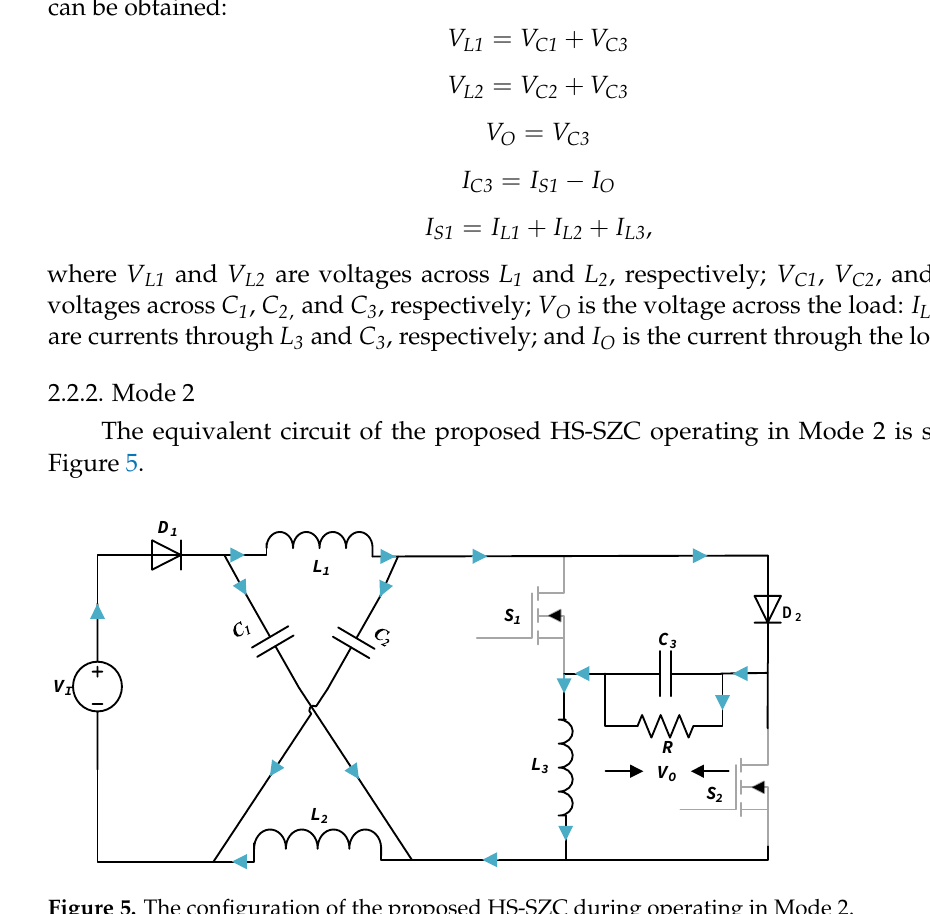
Figure 5. The configuration of the proposed HS-SZC during operating in Mode